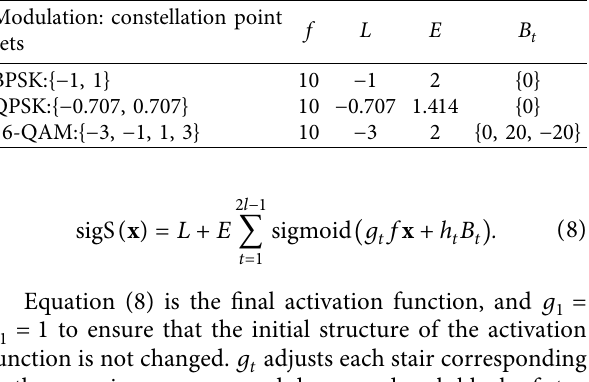
Figure 1: The structure of each unit in MsNet. Table 1: sigSum parameters for different